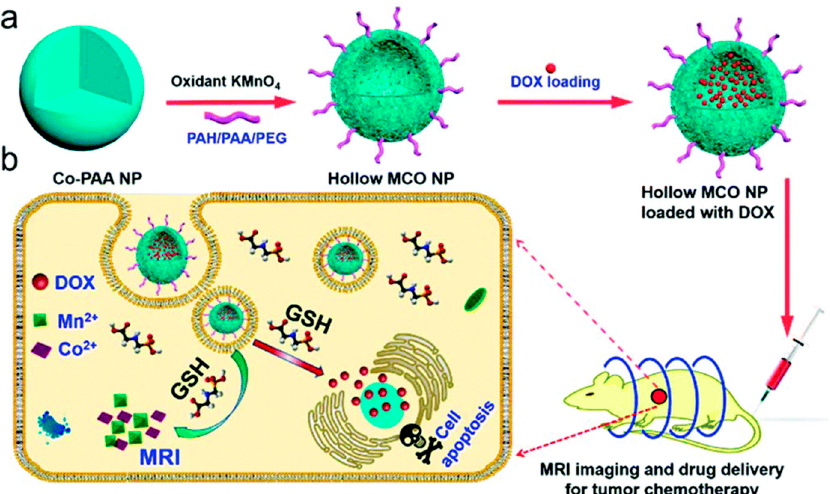
Figure 5. ( a ) Preparation and ( b ) application of CoNPs as glutathione-sensitive theranostic systems [131].